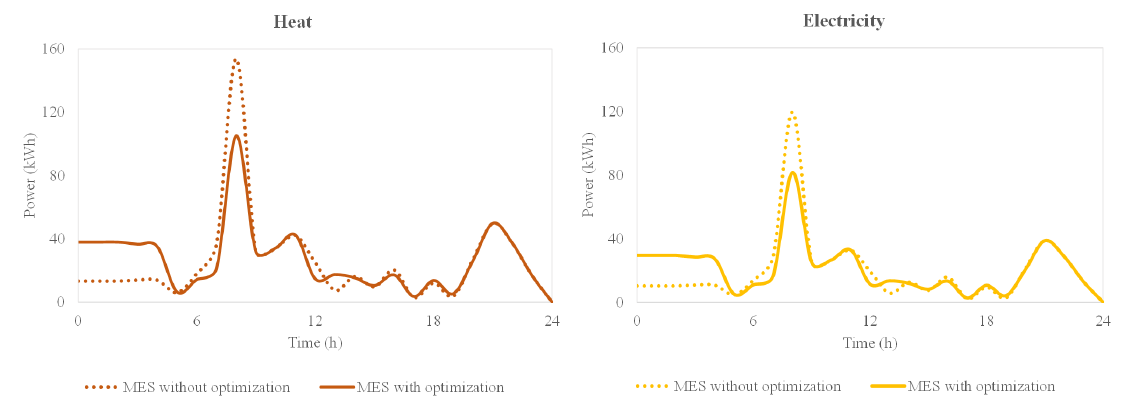
Figure 20. Provision of heat and electricity by the combined heat and power (CHP) unit of the